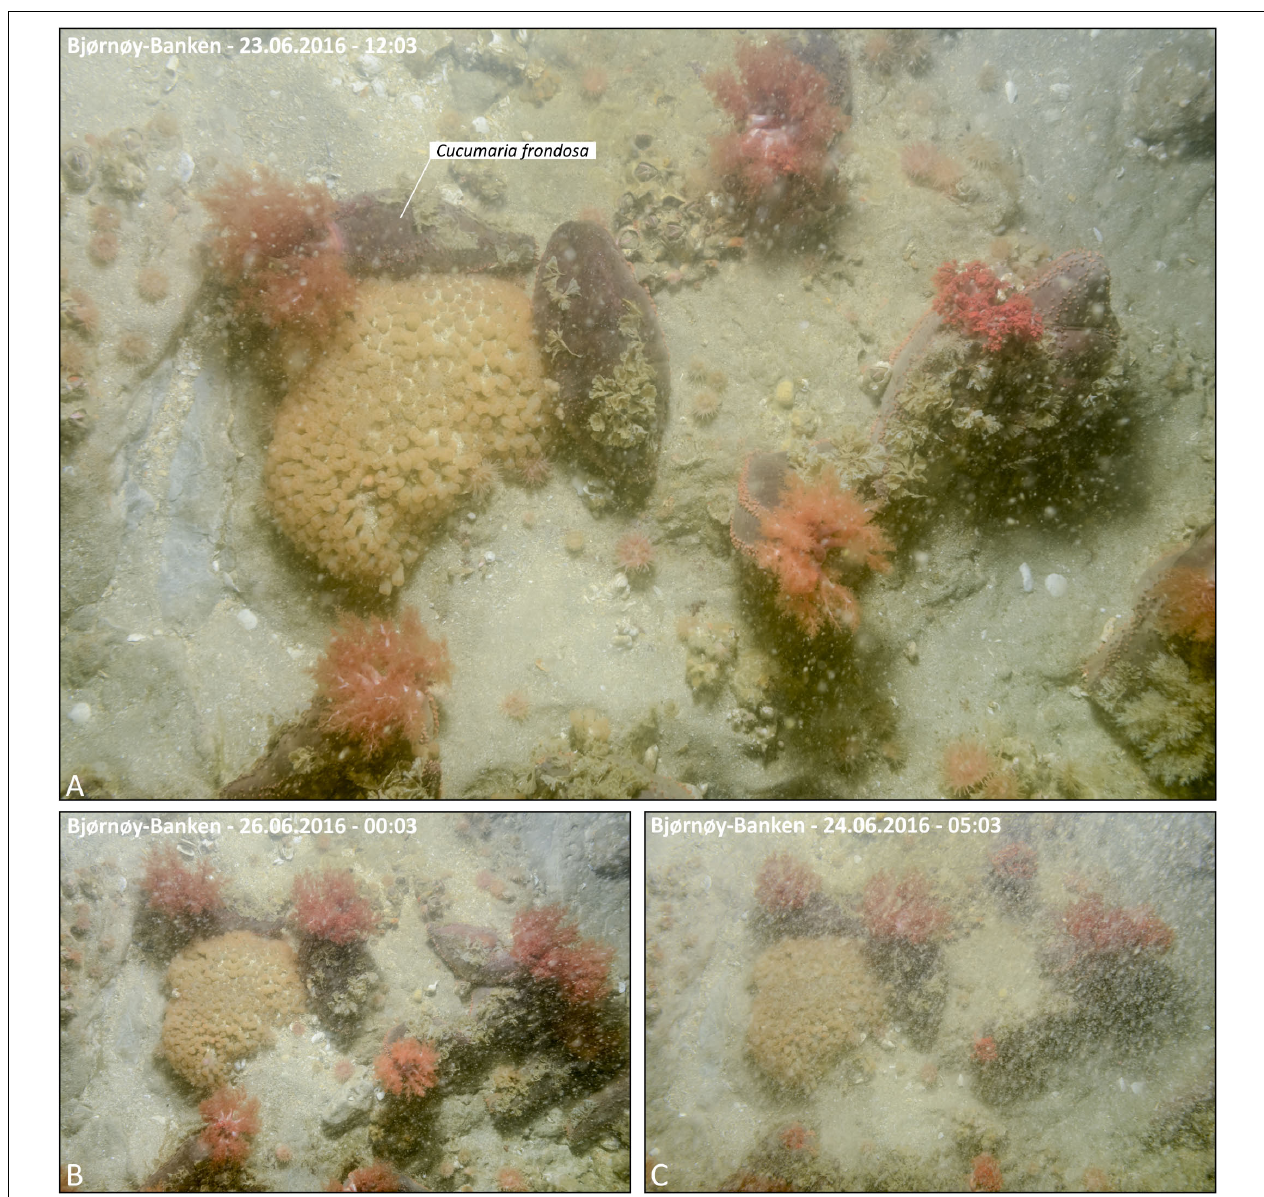
FIGURE 12 | Selected seafloor images (field of view = 86 × 57 cm) taken by the lander’s camera system during the 3 days of deployment at 46 m water depth on the carbonate platform at Bjørnøy-Banken: (A) First image in the series with several specimens of the large holothuroid Cucumaria frondosa , which was analysed for feeding activity. (B) Last image in the series for comparison. (C) An image taken during one of the tidal-induced phases with high currents and turbidity, leading to low contrast images, and prohibiting analysis of feeding activity except for the large